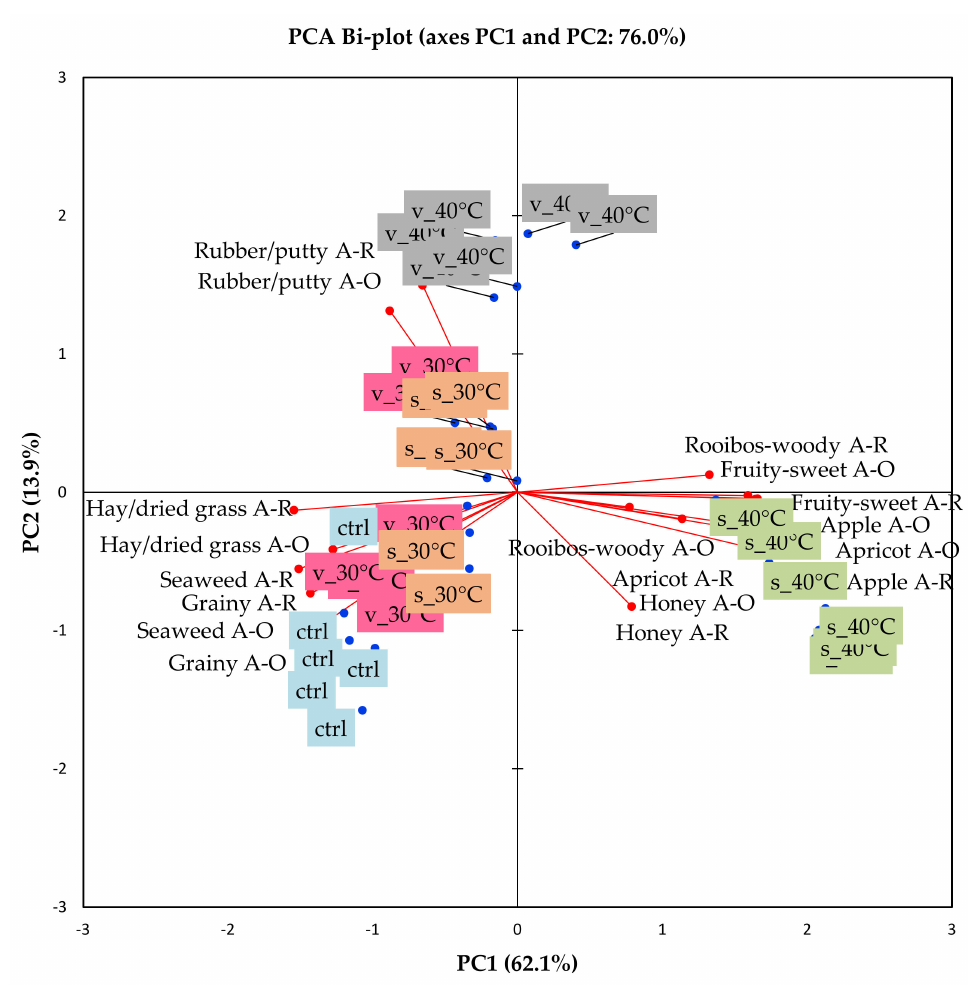
Figure 5. Principal component analysis (PCA) bi-plot showing the position of selected sensory attributes (orthonasal (A-O) and retronasal (A-R) aroma) in relation to M3 reconstituted in water to beverage strength (green rooibos extract microencapsulated with inulin in 1:1 ratio (m/m), xylitol, and citric acid), before storage (control, ctrl) and stored at 30 ◦ C/65% RH and 40 ◦ C/65% RH for 1 month in sealed glass vials ( v ) and semi-permeable sachets ( s